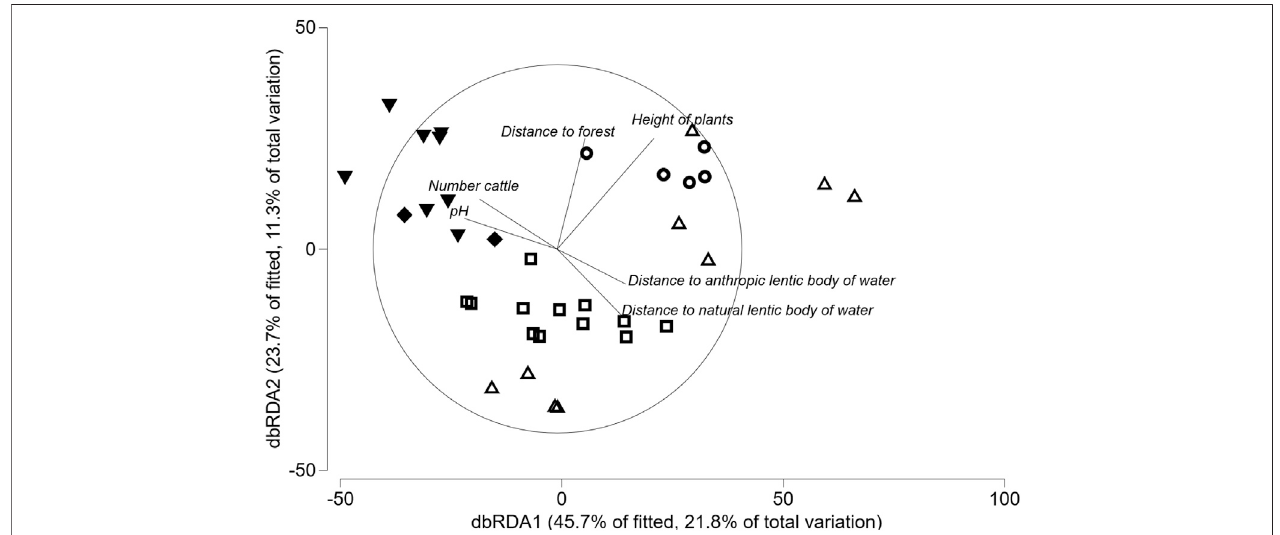
FIGURE3| Distance-basedredundancyanalysisofchangesinanuranassemblagesbasedonchangesinenvironmentalvariablesin fi vebodiesofwaterintropical fl ooded savanna of the Yopal Municipality (Casanare Department, Colombia). Based on the best fi tted model (DistLM), the fi rst two dbRDA axes explained 32.6% of the variation in the anuran assemblage structure along bodies of water. Vectors correspond to the four most important environmental variables explaining changes in the anuran assemblage. The direction and the association strength between the environmental variables and the ordination axis are represented by arrow orientation andlength.Geometric fi guresrepresenteachbodyofwatersurveyedindifferenttimesoftherainyseason,asfollows:naturalponds( Δ Pondintheedgeofgalleryforest; □ Pond in savanna; ○ Pond in the ecotone between savanna and road); and anthropogenic puddles ( ▼ Puddle in pasture; and ◆ Puddle on road).